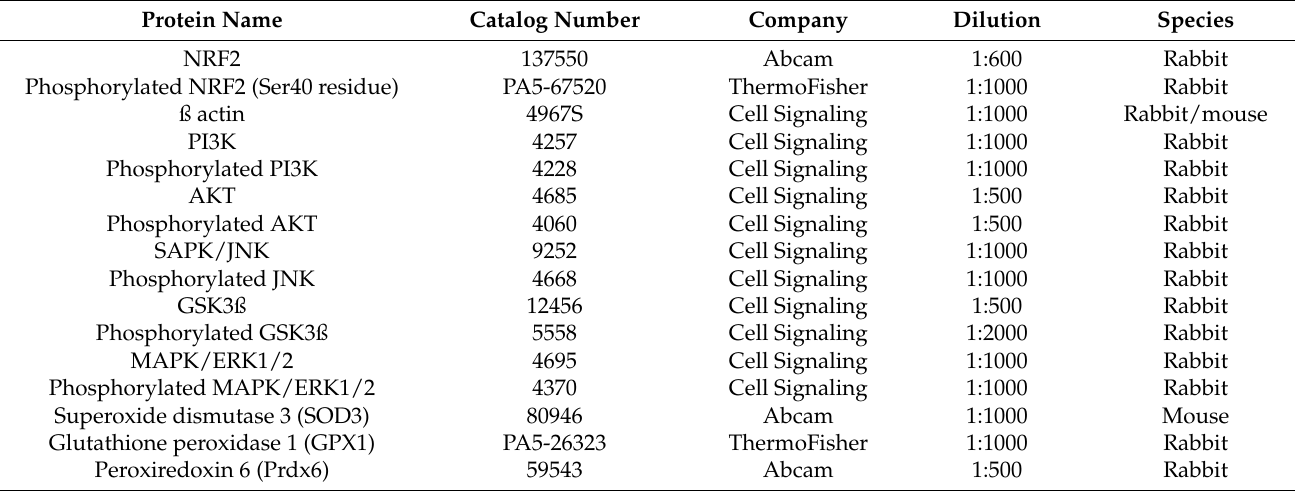
Table 2. Table of antibodies used for Western blot